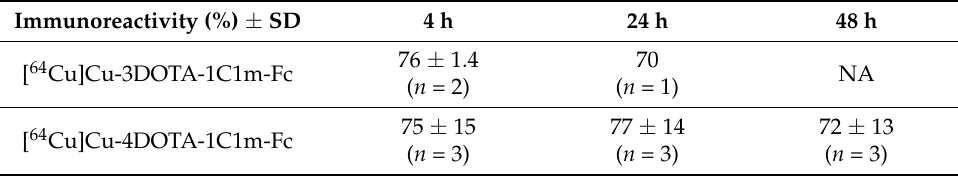
Table 1. Immunoreactivity assessment of [ 64 Cu]Cu-1C1m-Fc after incubation in serum. The results are expressed as mean ±